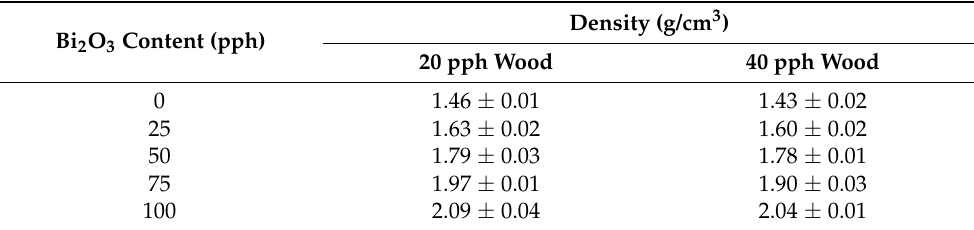
Table 2. Densities of WPVC composites containing varying contents of Bi 2 O 3 and wood particles (0–100 pph in 25 pph increments and 20 to 40 pph, respectively), where results are shown as mean ± standard deviation of the mean. Bi 2 O 3 Content